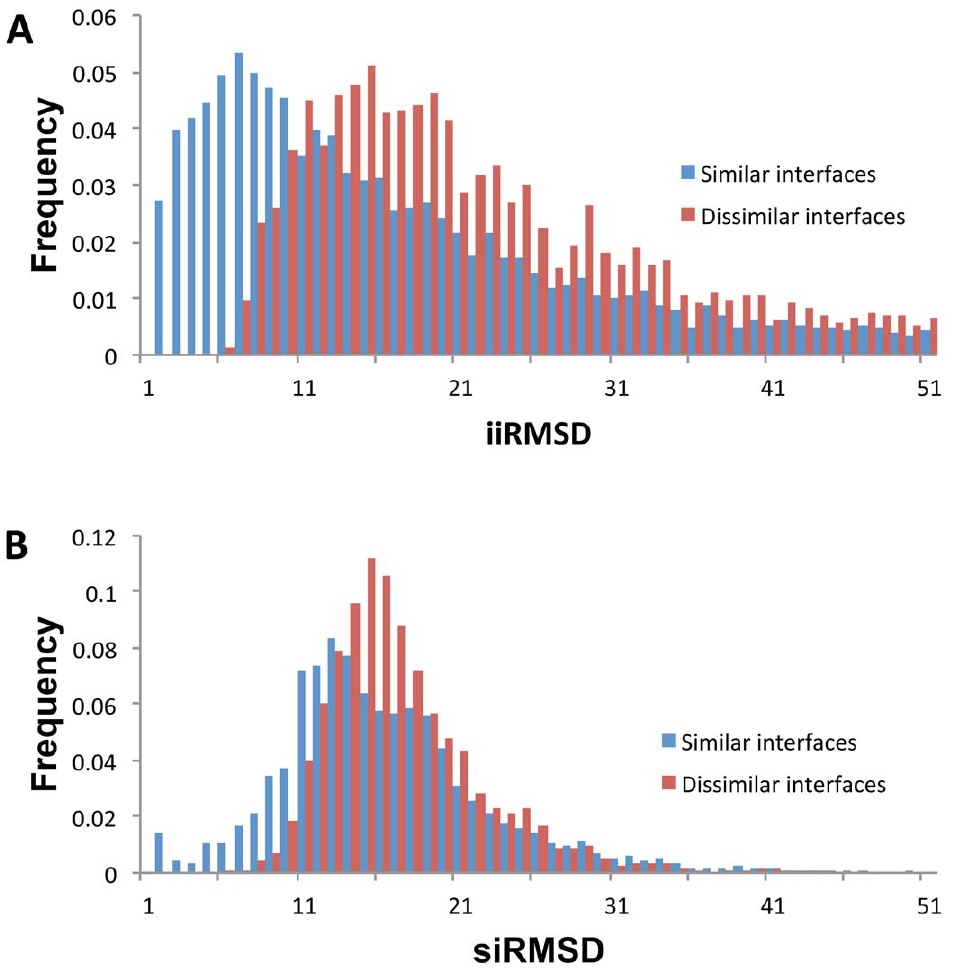
Figure 4. Histograms of the distributions of (A) iiRMSD and (B) siRMSD values on the datasets of similar and dissimilar interfaces. Both datasets are obtained from 3D Complex database. On average, the dissimilar interface pairs had larger iiRMSD and siRMSD values (mean values are 20.6 and 15.8, correspondingly) than similar pairs (mean values are 14.8 and 14.7). In addition, the mean value difference between the similar and dissimilar interfaces was larger when using the iiRMSD measure ( Dm is 4.7 for iiRMSD and 1.1 for siRMSD ).